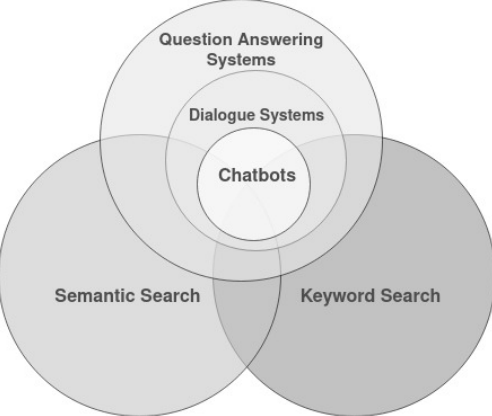
Figure 1. The interaction of different types of the search services.